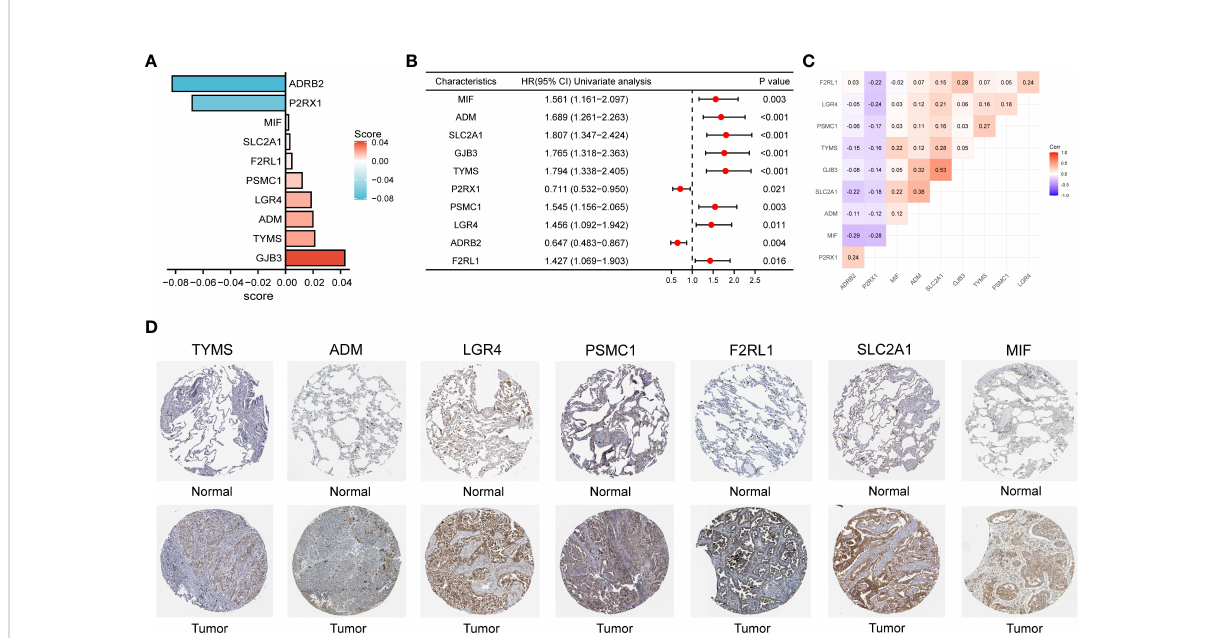
FIGURE 4 (A) The bar charts display the variables and corresponding coef fi cients in the prognostic signature. (B) The forest plot shows the results of hazard ratios and 95% con fi dence intervals of signature genes from the univariate Cox regression analysis. (C) The correlation matrix illustrates the correlations between genes involved in the prognostic signature. (D) Representative immunohistochemical staining images of TYMS (antibody HPA074922, 10×), ADM (antibody CAB016075, 10×), LGR4 (antibody HPA030267, 10×), PSMC1 (antibody HPA016885, 10×), F2RL1 (antibody CAB012989, 10×), SLC2A1 (antibody CAB002759, 10×), and MIF (antibody CAB005284, 10×) in normal and LUAD tissues are retrieved from The Human Protein Atlas database (HPA, https://www.proteinatlas.org/, accession date: April 2022). It should be noted that the immunohistochemistry staining of ADRB2 , P2RX1 , and GJB3 were absent from the HPA